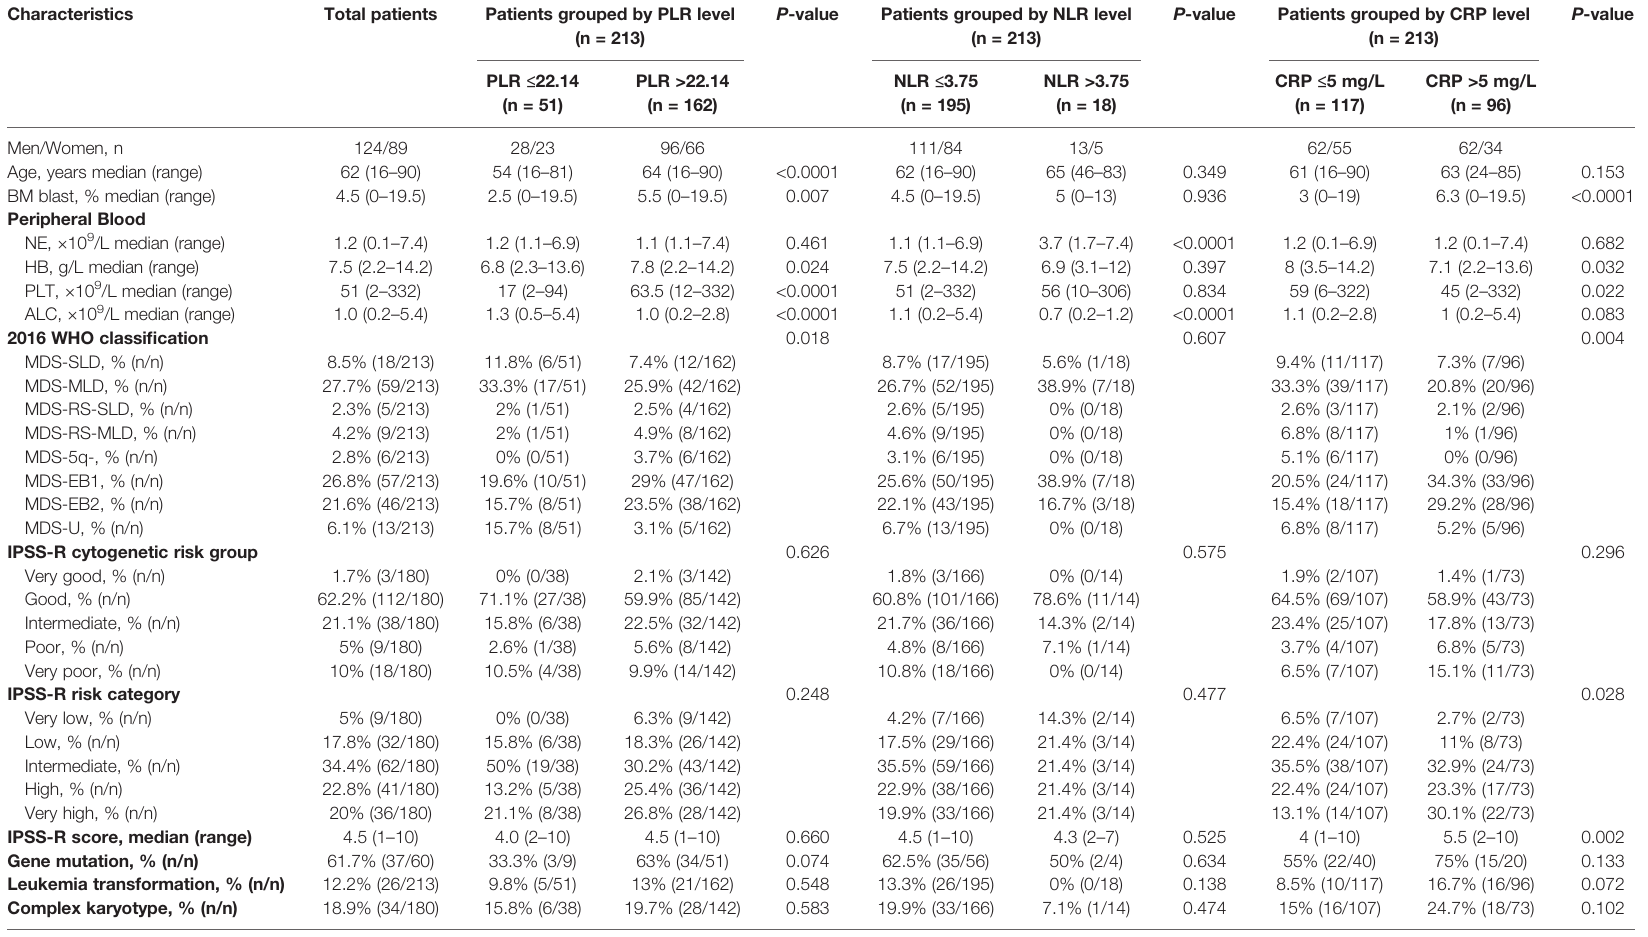
TABLE 1 | Baseline patient characteristics according to total patients, PLR, NLR, and CRP